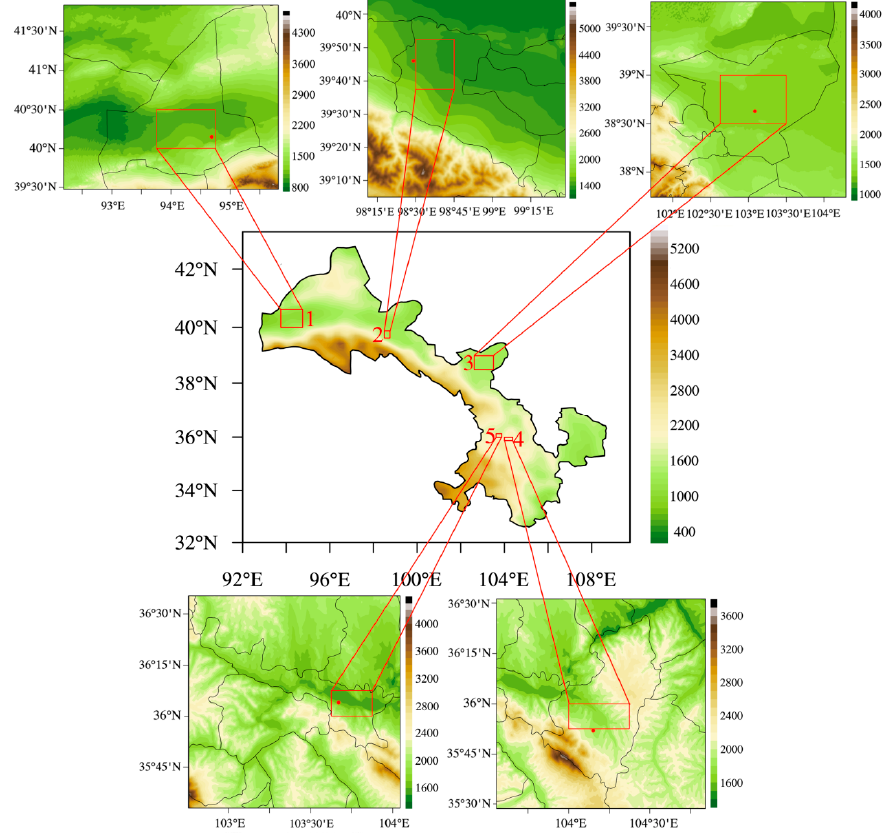
Figure 1. Scope of research and each representative region’s topography, and a grid point data range diagram. 1: Dunhuang, 2: Jiuquan (Suzhou District), 3: Minqin, 4: Yuzhong, and 5: Lanzhou (urban). The red dots indicate the location of the sounding station. The red boxes indicate the grid point data range of the ERA-Interim (ECMWF Reanalysis data, ECMWF: European Centre for Medium-Range Weather Forecasts) mode level